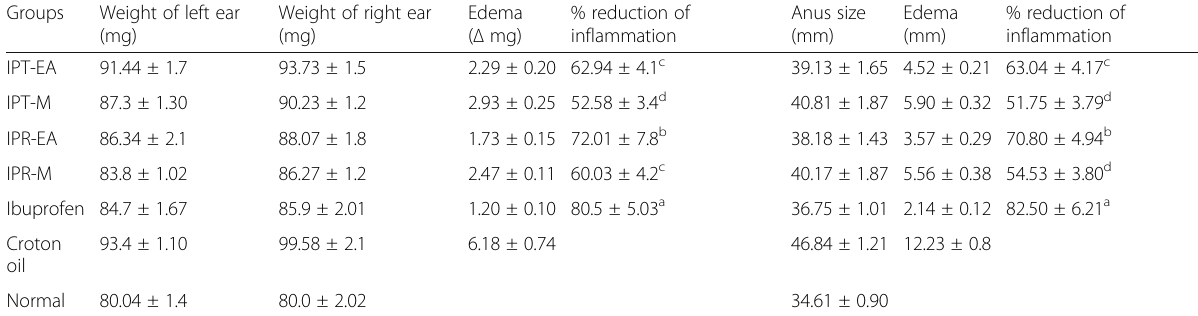
Table 6 Effect of I. batatas on croton oil-induced ear and anal edema in rat Groups